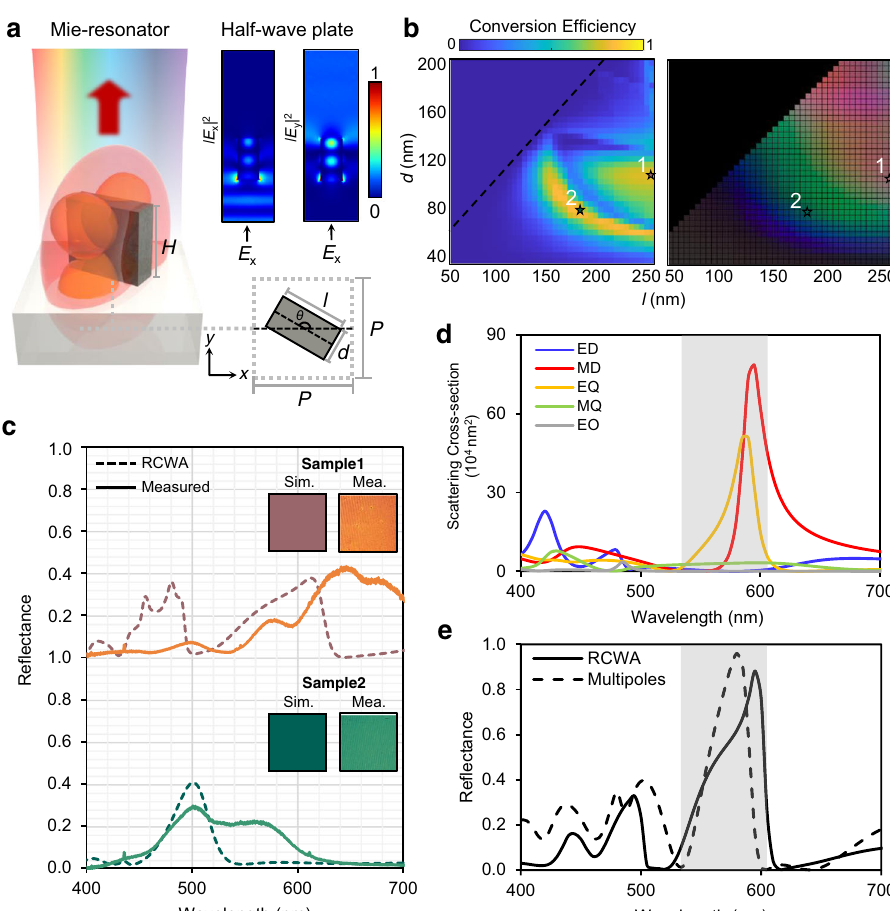
Fig. 2 Simultaneous manipulation of re fl ection spectrum and phase using asymmetric meta-atoms. a Schematic of the multifunctional meta-atom which acts as a Mie-resonator and a localized half-wave plate. The meta-atom has length l , height H , width d , pitch P , and an in-plane rotation angle of θ . b Cross- polarization conversion ef fi ciency at 532 nm and color palette of meta-atoms with l from 50 to 250nm and d from 40 to 200 nm, with H = 350 nm and P = 300 nm. c Re fl ection spectra of Samples 1 and 2. Dashed line: RCWA simulation; solid line: experimental measurement. Insets represent the calculated and measured colors of Samples 1 and 2. d Multipole decomposition of the scattering response of the meta-atom array in free space under linearly polarized light along the x -axis. The meta-atoms have l = 250 nm, d = 95 nm, H = 350 nm, and P = 300 nm. Gray colored area indicates the regime where the interplay between the strong MD and EQ modes occurs. e Comparison between the re fl ectance retrieved from the multipole moments and RCWA